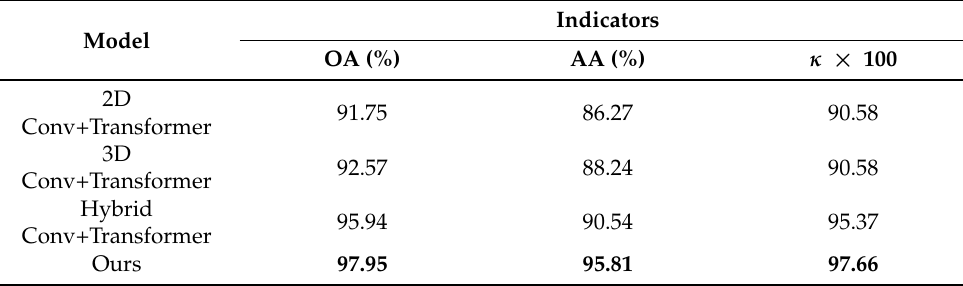
Table 5. Ablation Analysis of The Proposed Method on Indian Pines Data